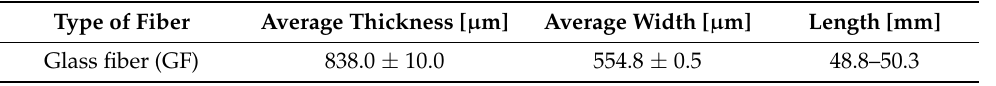
Table 3. Properties of the glass